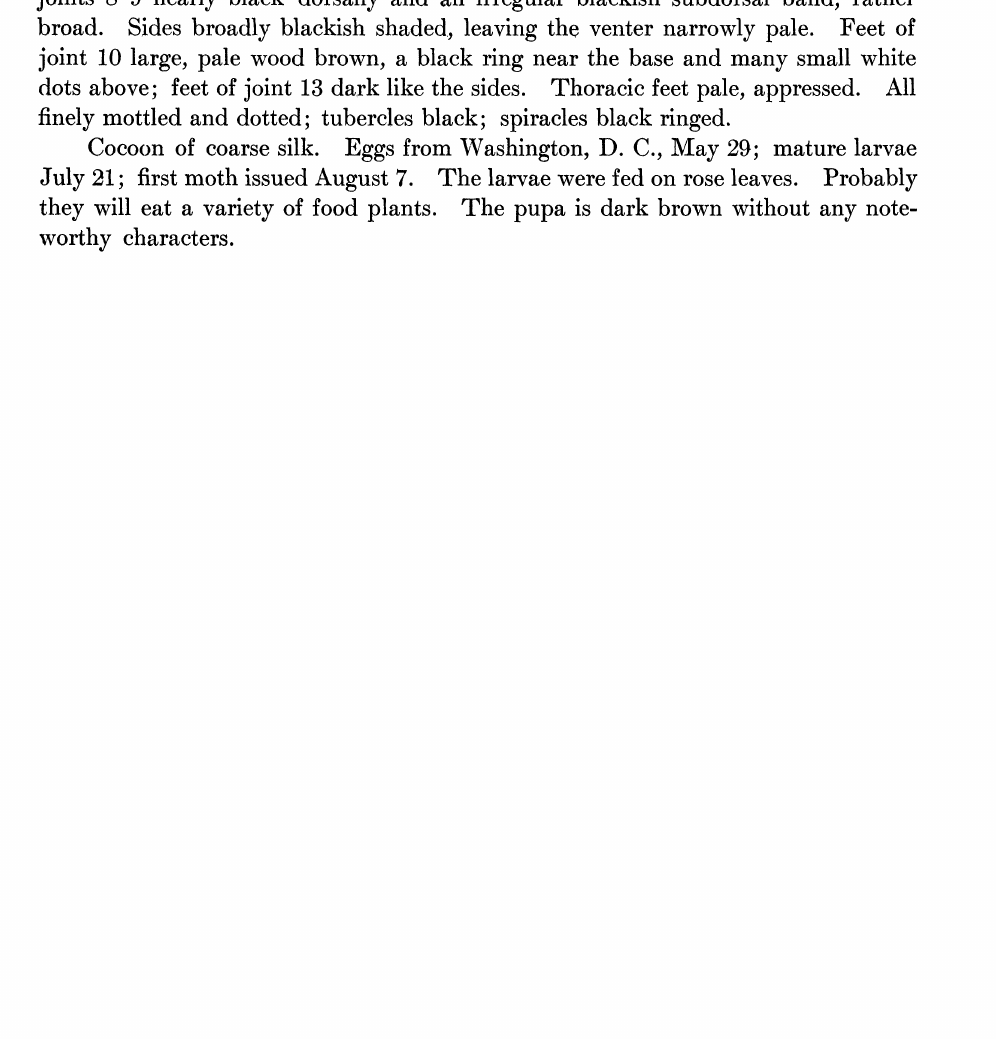
light whitish space dorsally on joints 5 to 7, illy defined, narrowed between the seg- ments, appearing again on joints 10 to 12 less broadly.